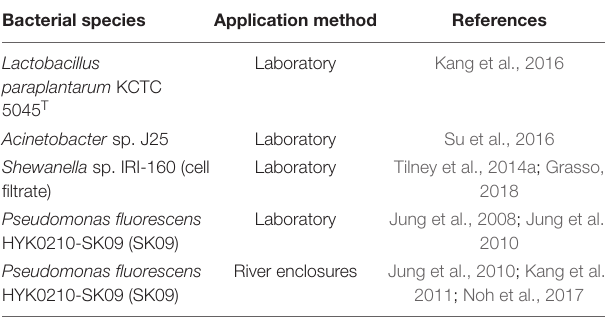
TABLE 2 | Select studies on algicidal bacteria or their filtrate using natural communities. Bacterial